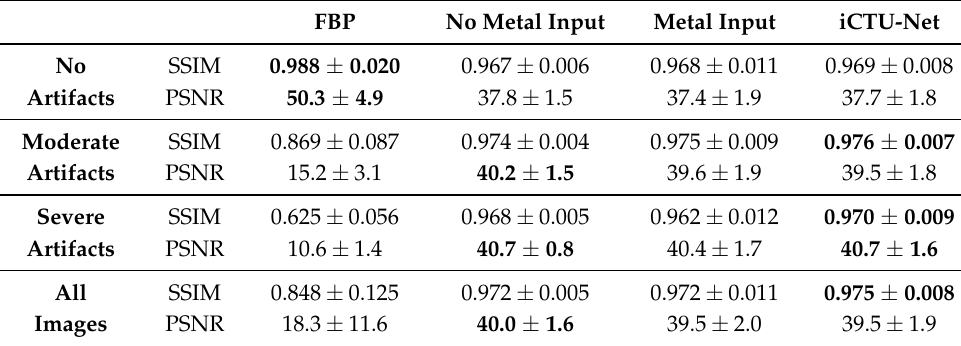
Table 2. SSIM and PSNR evaluation metrics for the input study. The differentiation of artifact severity is not meaningful for No Metal Input because none of the test data contain metal. Since this network is not trained with any metal data, it is not suitable for artifact reduction. However, to allow a reasonable comparison to the other methods, we keep the categories, meaning the same slices are used for evaluation. The best result for each metric is marked bold . FBP No Metal Input Metal